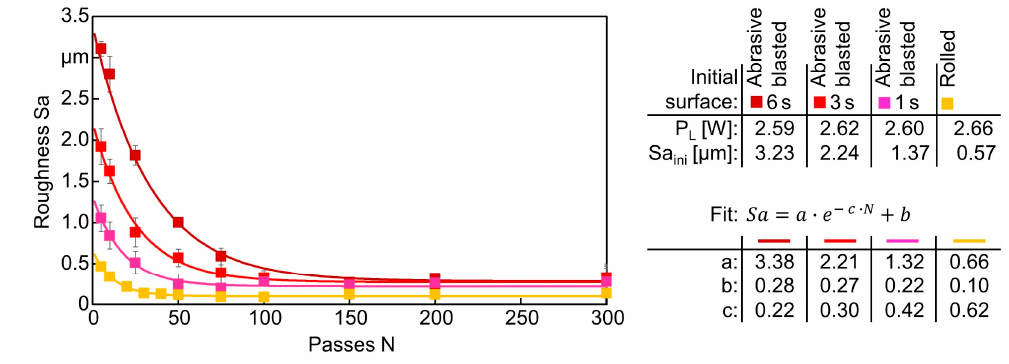
Figure 5. Microscopic images of the pre-machined and final surface finish after 300 passes.